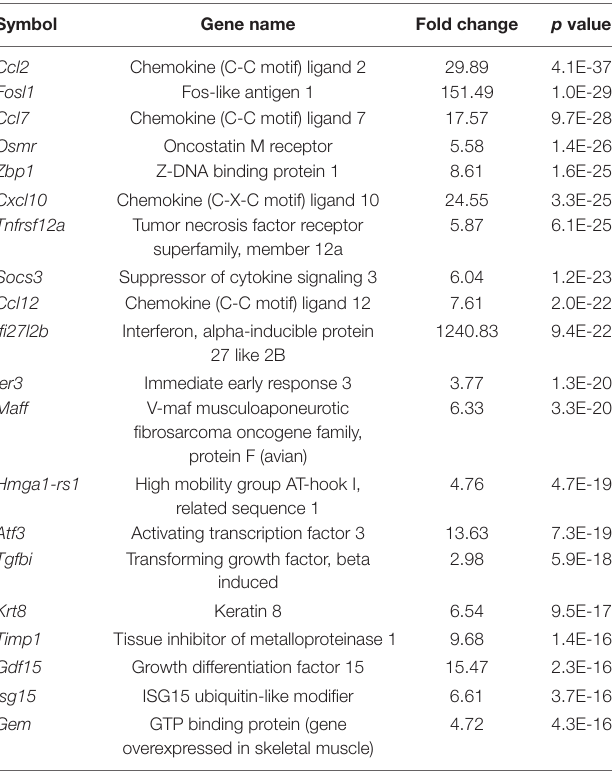
TABLE 1 | Top 20 upregulated pathways in the KEGG database, sorted according to p value. Pathway Gene count